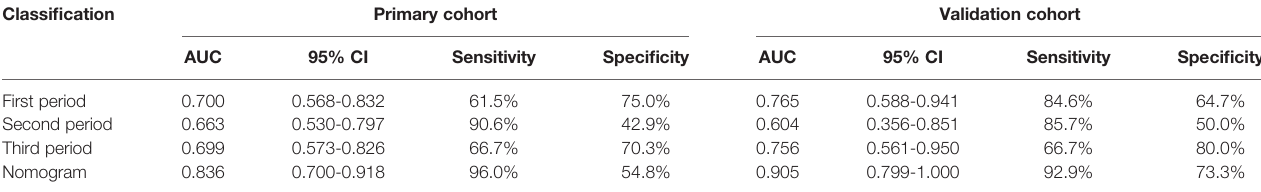
TABLE 4 | ROC curve parameters of the radiomics model and nomogram.